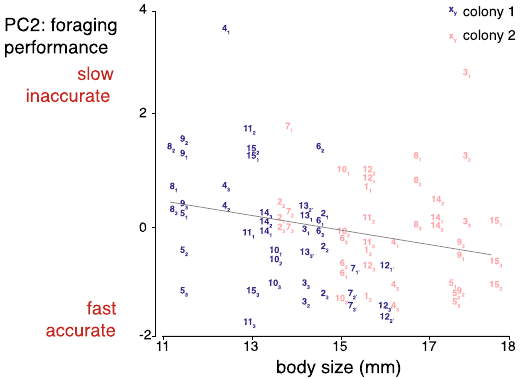
Figure 5. Inter-individual variance in foraging performance (PC2) is partly explained by body size (length from top of head to end of abdomen). Each data point represents the average score of an individual in an experimental array (three values per individual). Blue: colony 1 (N = 15 bees), red: colony 2 (N = 13 bees). Numbers refer to individual bees (the same number code was used in Figs 3 and 4). Subscripts refer to experimental arrays (1–3). Marginal R 2 = 0.12, conditional R 2 =